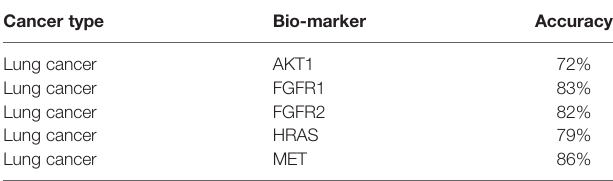
TABLE 2 | Accuracy of lung cancer biomarkers.